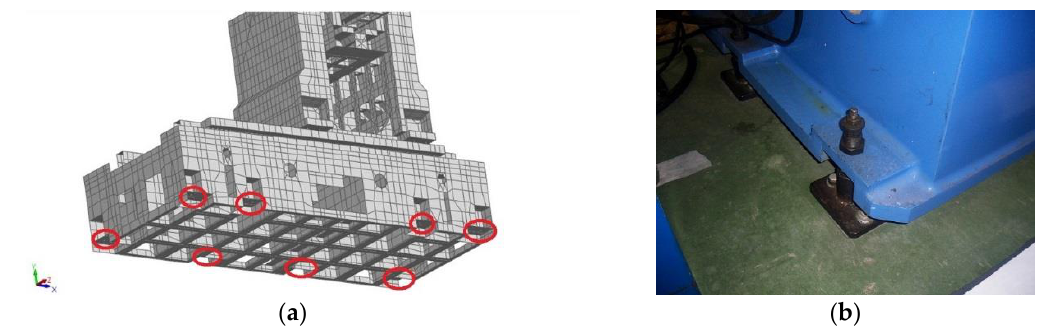
Figure 5. Supporting mounts of the machining center in a ( a ) FE model and ( b ) photograph.